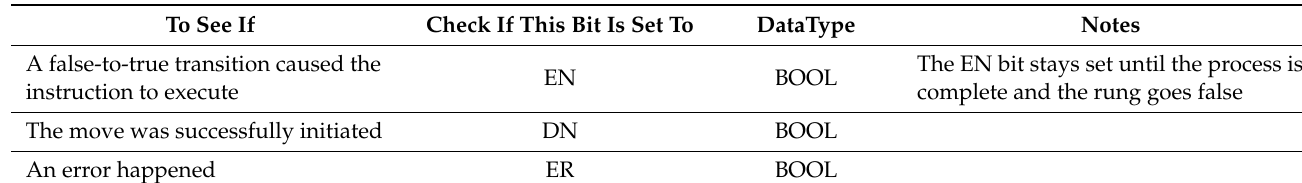
Table 2. Motion Axis Move Status Bit Behaviour from [50].